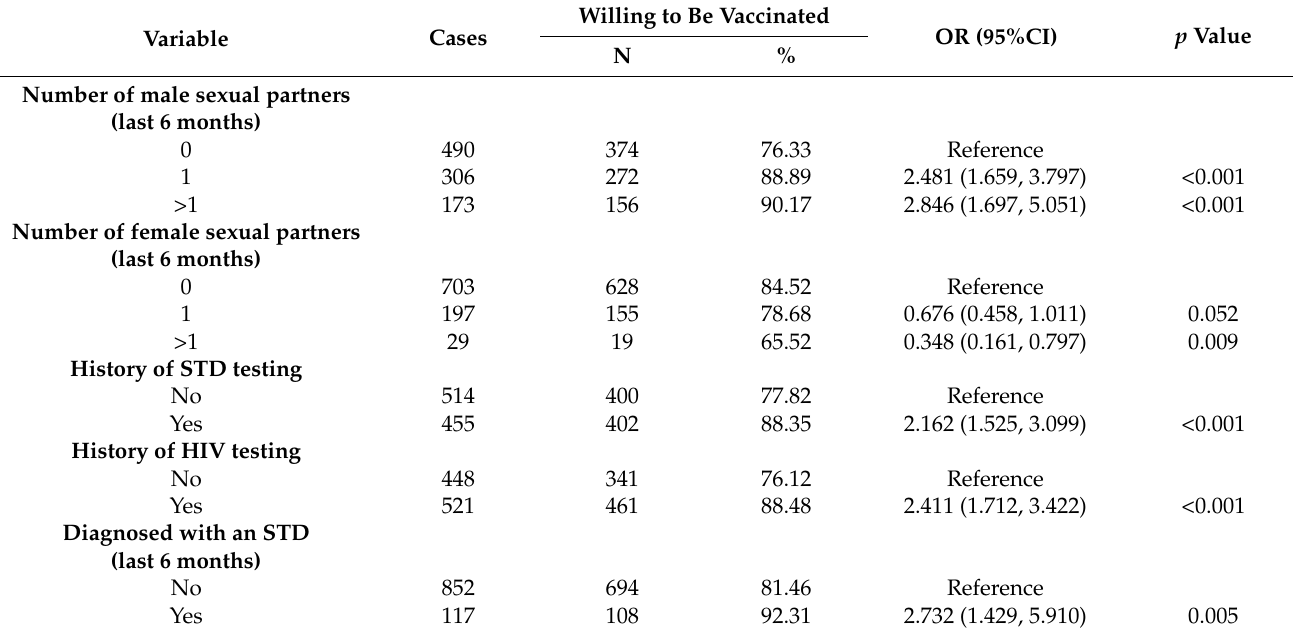
Table 2. Comparison of differences in HPV vaccination willingness among different behavioral characteristics in